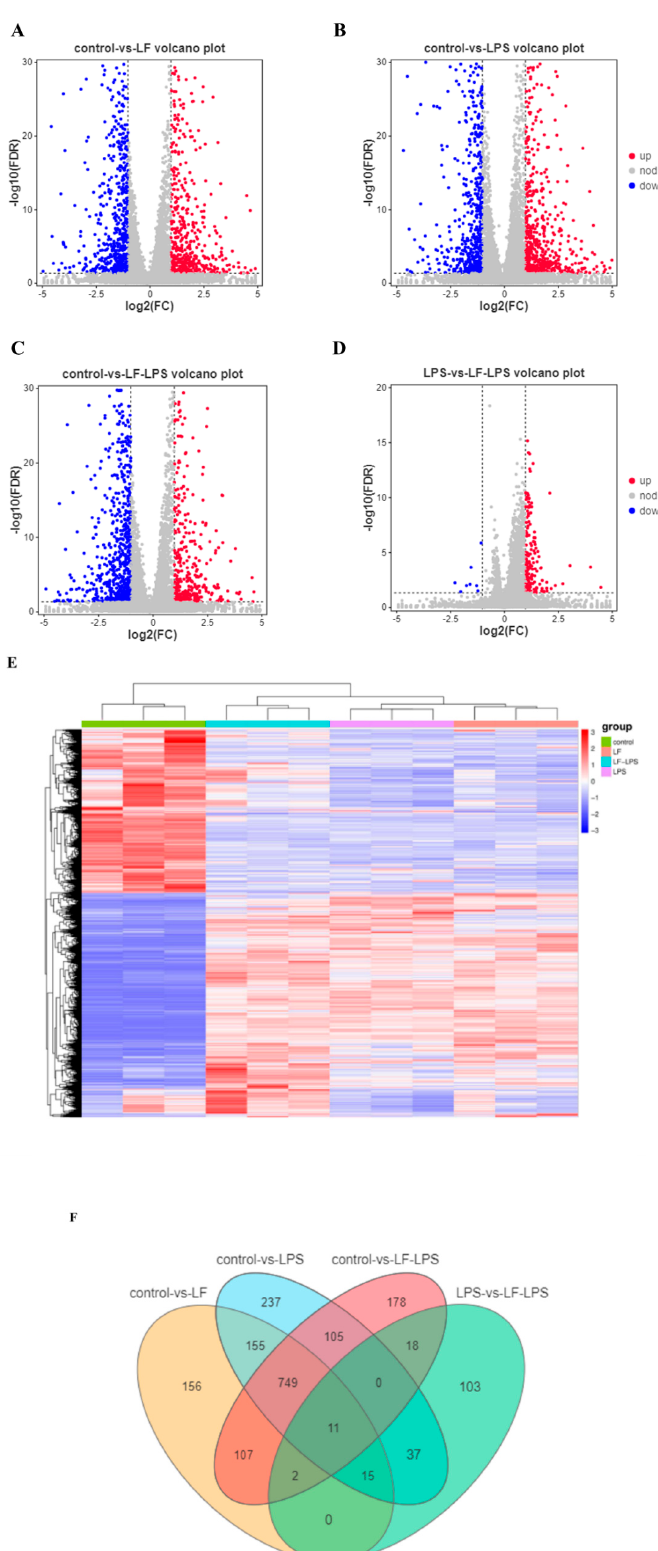
Figure 2. Differential expressed gene (DEGs) analysis of primary IECs in the co-culture system. ( A – D ) The number of DEGs screened by group comparison. ( E ) Heatmap of all DEGs. ( F ) Venn analysis between DEGs with different treatments. LF represents apo-LF. Apo-LF represents individual treatment with 10 g/L apo-LF, LPS represents individual treatment with 1 mg/L LPS and apo-LF + LPS represents combined treatment with of 10 g/L apo-LF and 1 mg/L LPS.